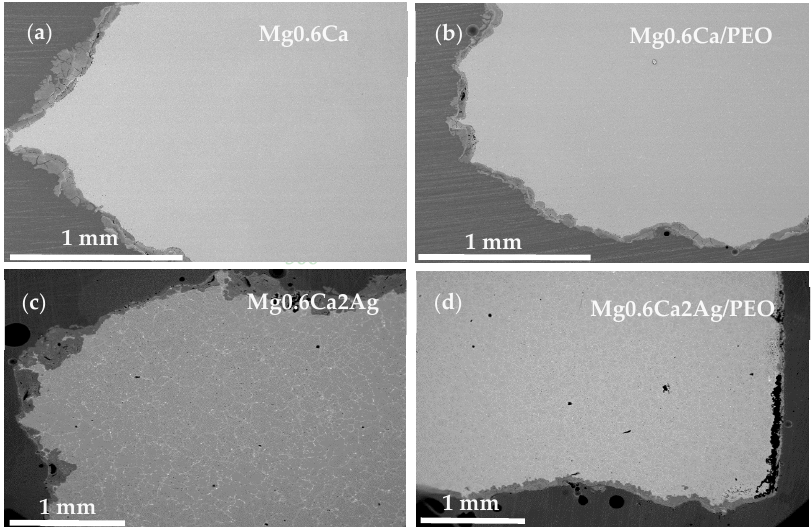
Figure 10. 3D macrograph of ( a ) Mg0.6Ca, ( b ) Mg0.6Ca/PEO after 60 days, ( c ) Mg0.6Ca2Ag and ( d ) Mg0.6Ca2Ag/PEO after 4 days of immersion in m-SBF.